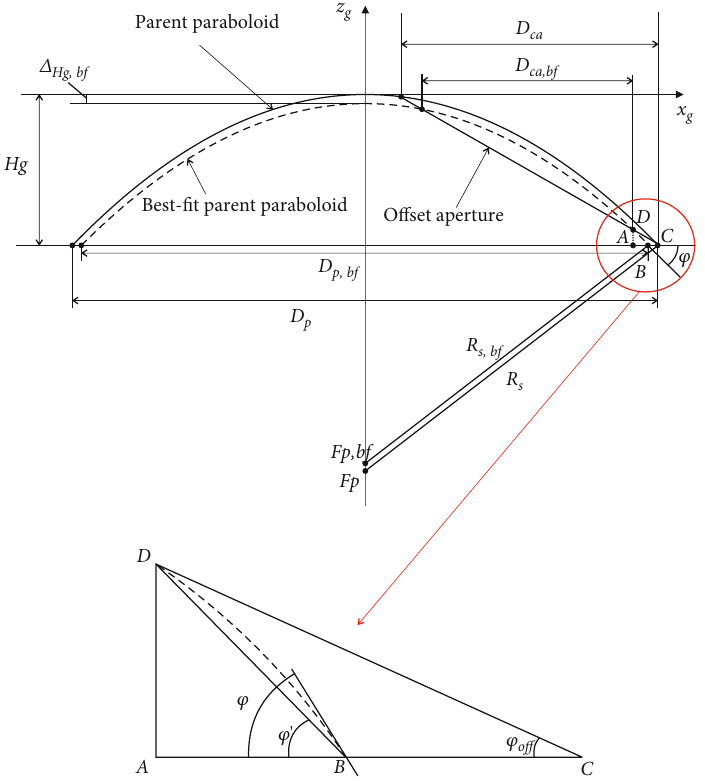
Figure 9: The best- fi t surface for an o ff set-feed parabolic re fl ector in the x